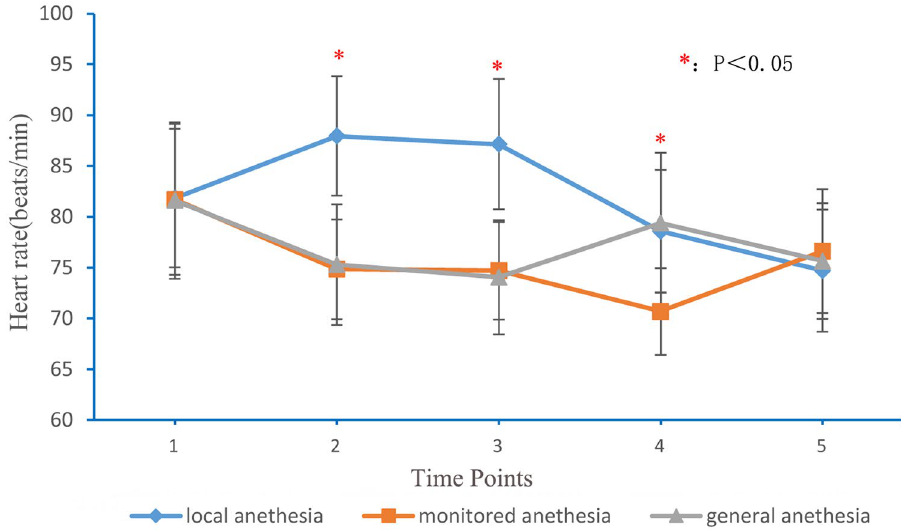
Figure 2. Heart rate at different time points for local anesthesia, monitored anesthesia and general anesthesia groups. 1: 1 h before anethesia; 2: puncture of trocar into vertebral body; 3: injection of bone cement into vertebral body; 4: 2 h after operation; 5: 1 day after operation.